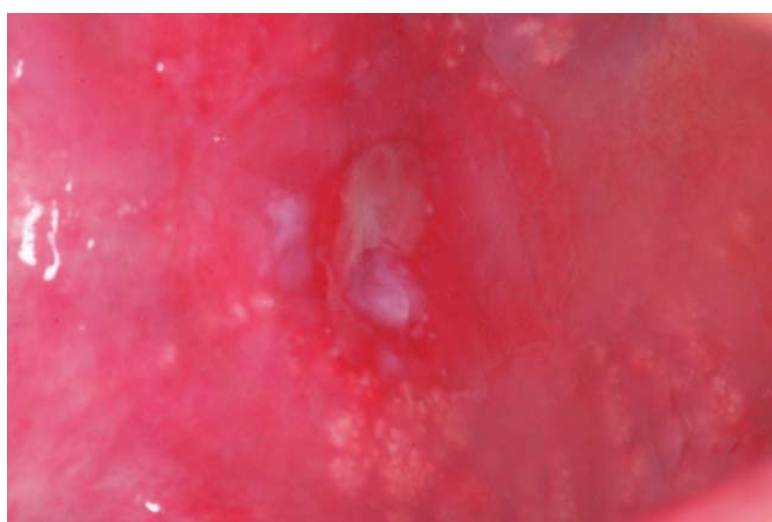
Figure 1- Clinical aspect of the right buccal mucosa: ulcer with an erythematous halo and small white plaques in the center of the picture